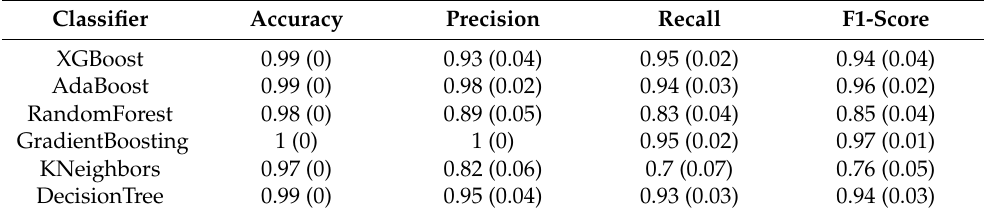
Table 9. Models’ performance for Gaussian Spreading after applying class weight (standard deviation in brackets).